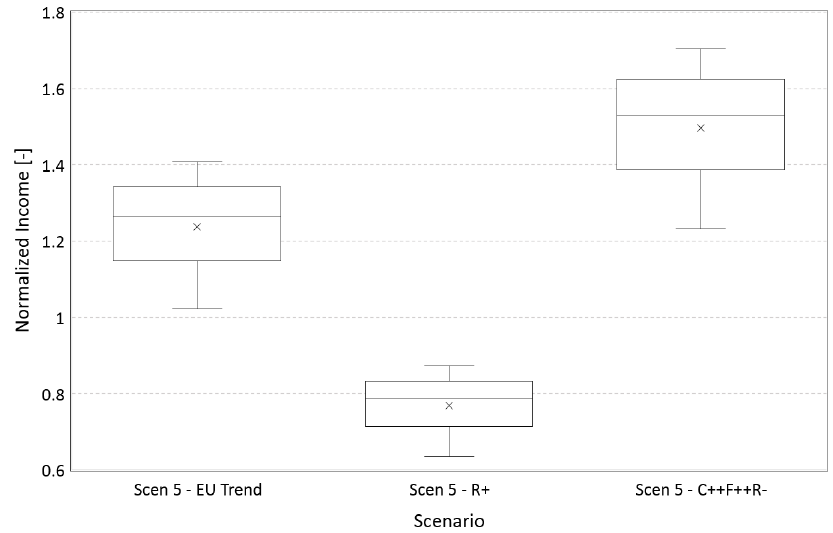
Figure 7. Boxplots of normalized incomes (according to 2015) for 2030 mixed scenarios.